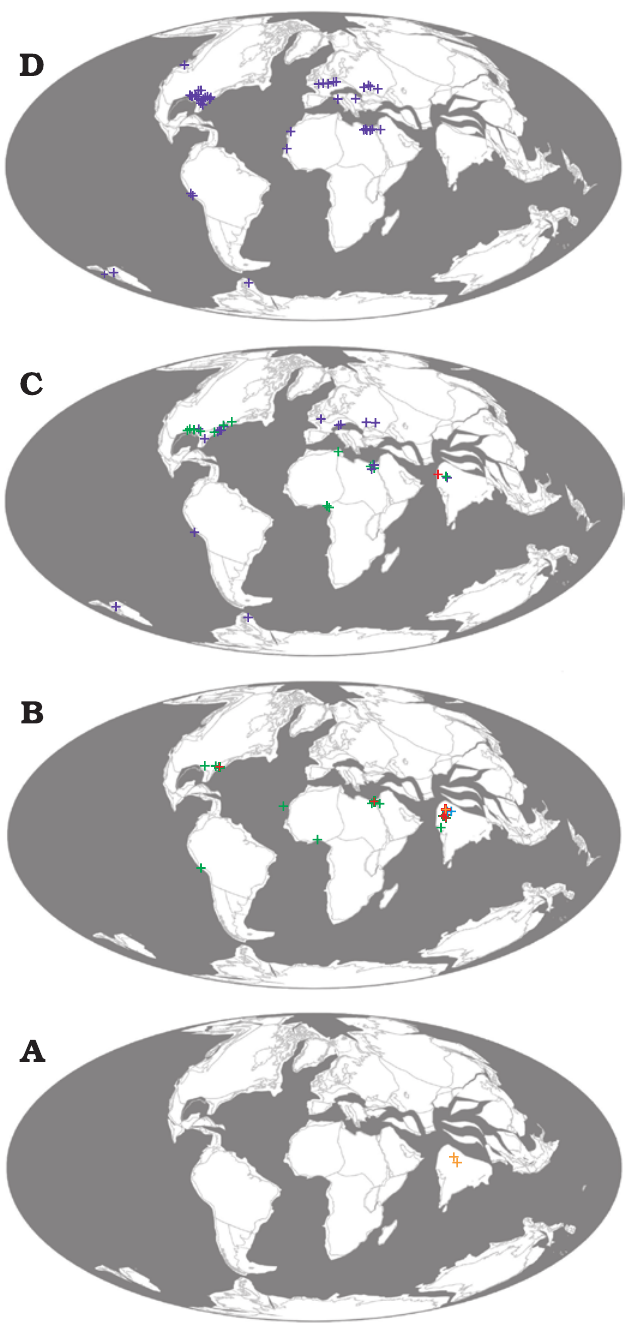
Fig. 3. Paleogeographic reconstructions and distributions of Eocene ceta- ceans. A . Ypresian, reconstructed at 52 Ma. B . Lutetian, reconstructed at 45 Ma. C . Bartonian, reconstructed at 40 Ma. D . Priabonian reconstructed at 36 Ma. Data are derived from occurrences in the Paleobiology Database and includes every published occurrence of archaeocete cetaceans (Uhen